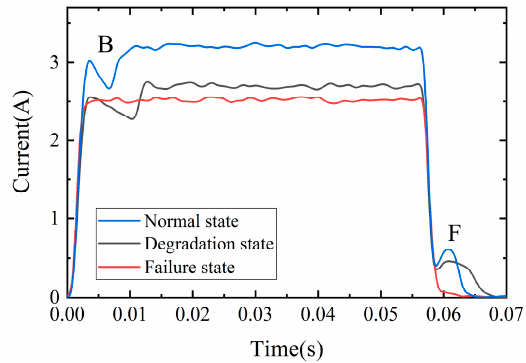
Figure 9. Current diagram under three states.